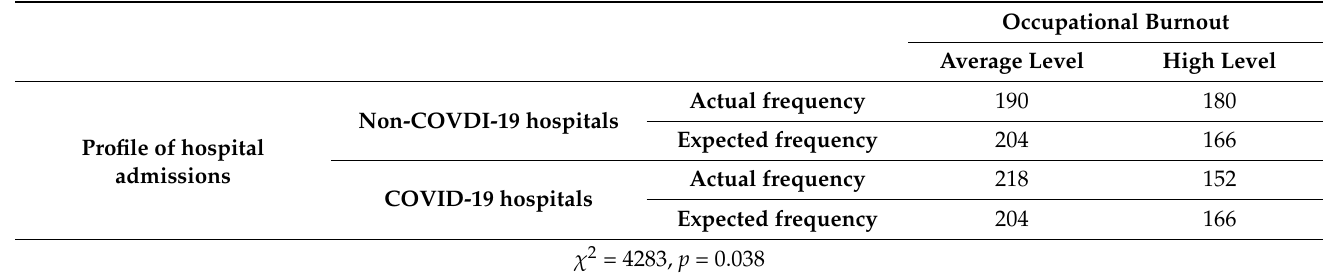
Table 4. The relationship between ICU HCWs’ occupational burnout and the profile of hospital